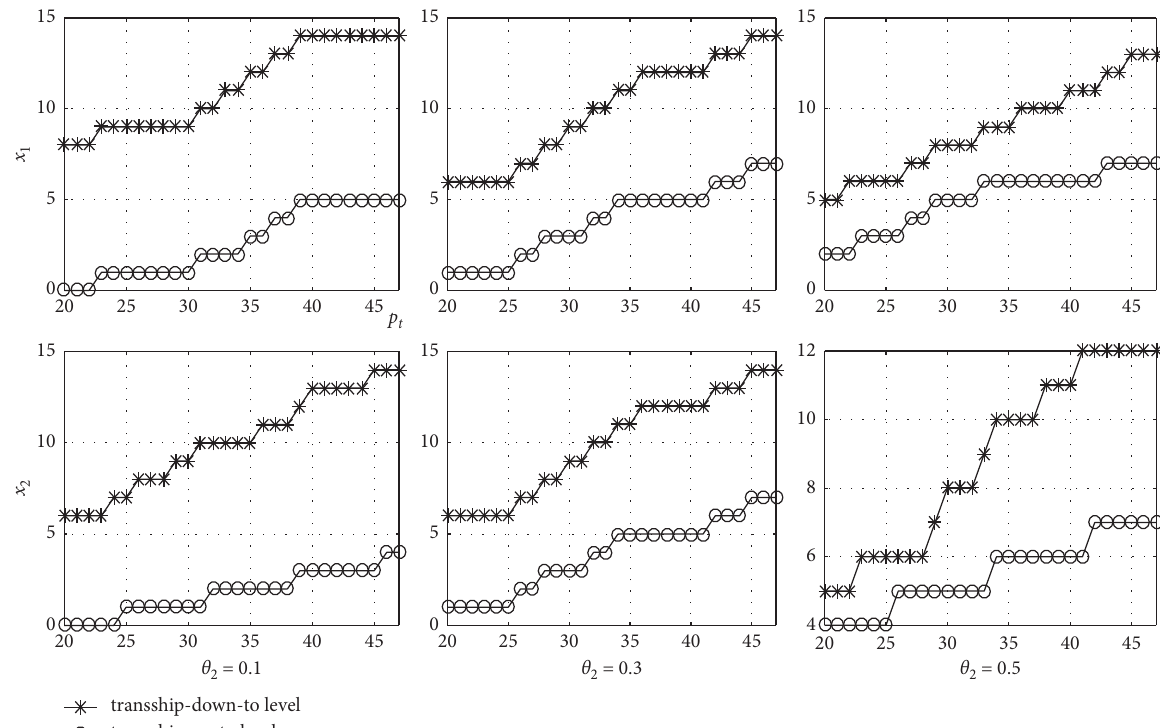
Figure 2: Relationship of the transshipment lower and upper levels with the switching rate.